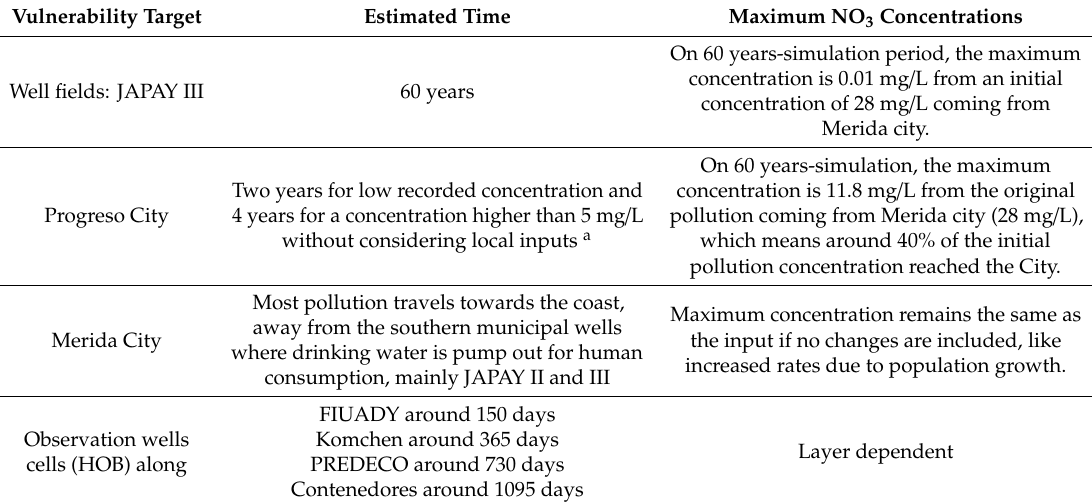
Table 3. Estimated time and NO 3 concentrations to be considered for an integrated groundwater vulnerability